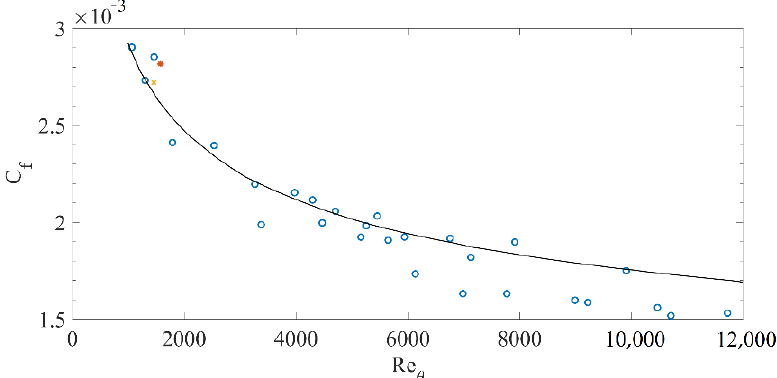
C with the experimental data:  , simulation data f